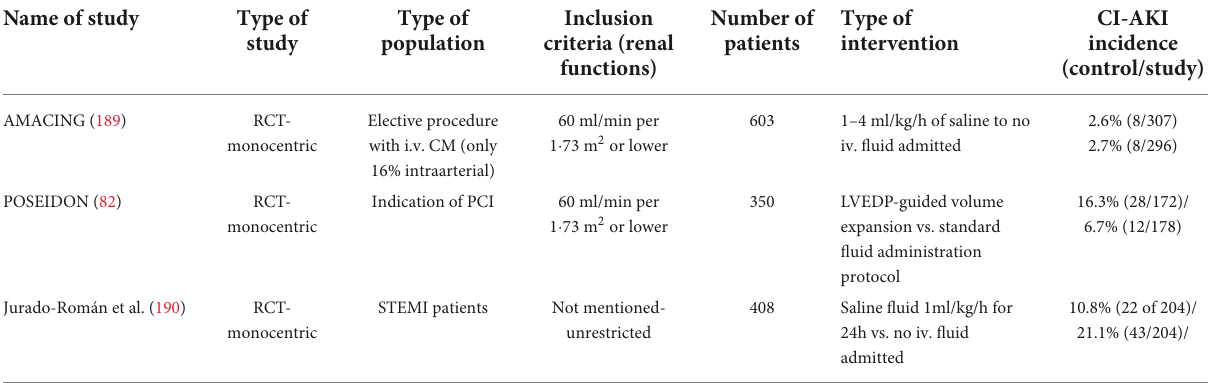
TABLE 5 Randomized controlled trials comparing hydration as prevention method of CI